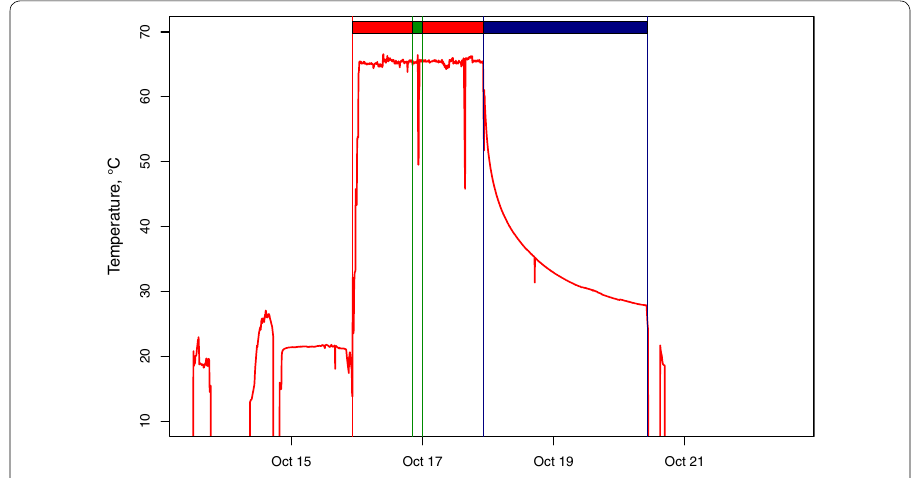
Fig. 13 Development of the temperatures during production stage 0 ( T Inj = 65 ◦ C ). The colored bars at the top symbolize injection (red), calibration of the probe (green) and production (blue)